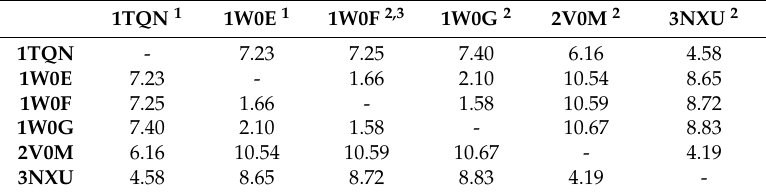
Table 1. Superimposition of C-alpha carbon atoms of the crystal structure of